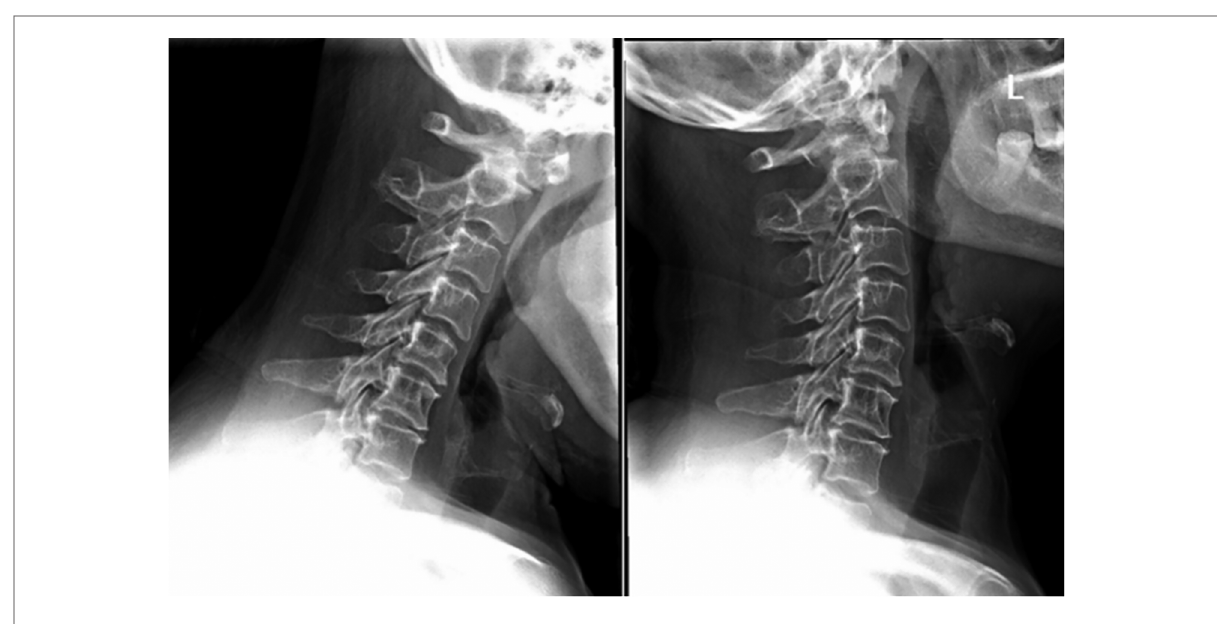
FIGURE 1 Preoperative x-ray revealing atlantoaxial instability.